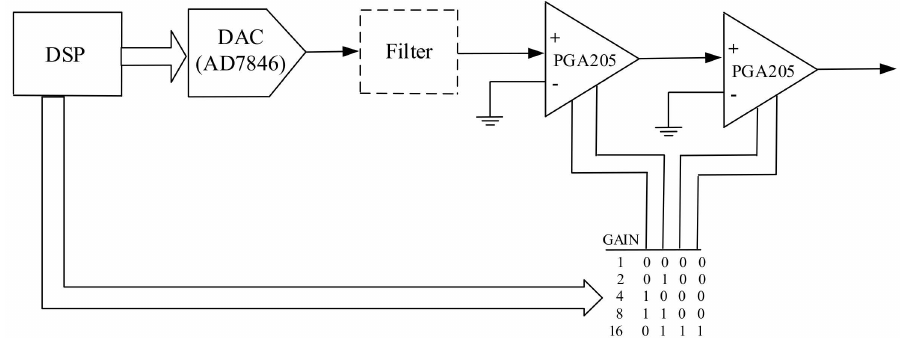
Figure 2. Schematic diagram of PGA amplification method